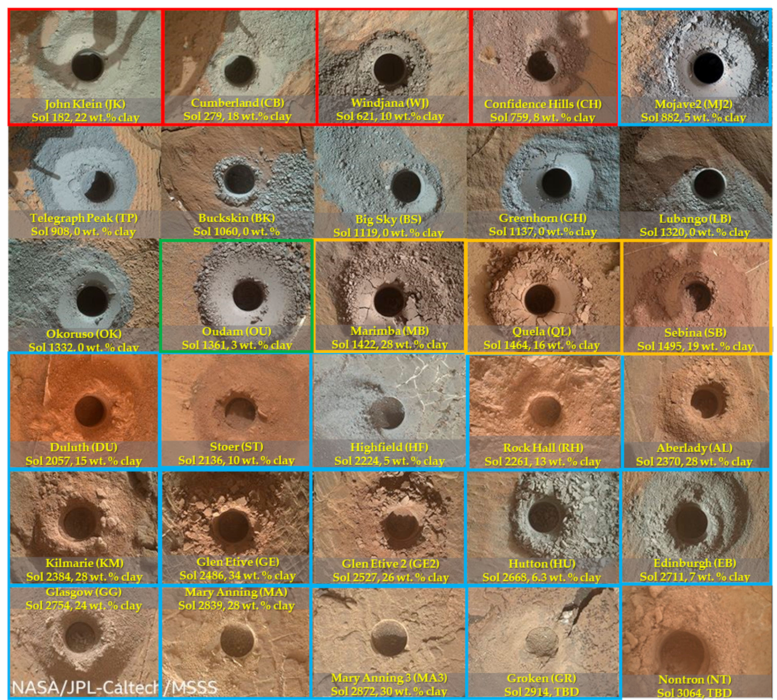
Figure 8. Gale crater drill hole sites imaged by MAHLI (30). Drill holes are approximately 1.5 cm in diameter and reach a depth of up to ~4–6 cm. Trioctahedral clay samples are outlined in red, dioctahedral in blue, both tri- and dioctahedral in orange, and ferripyrophyllite in green. Drilled powered samples exhibit a range of grey and reddish colors that reflect mineralogical changes from alteration and fluid:rock